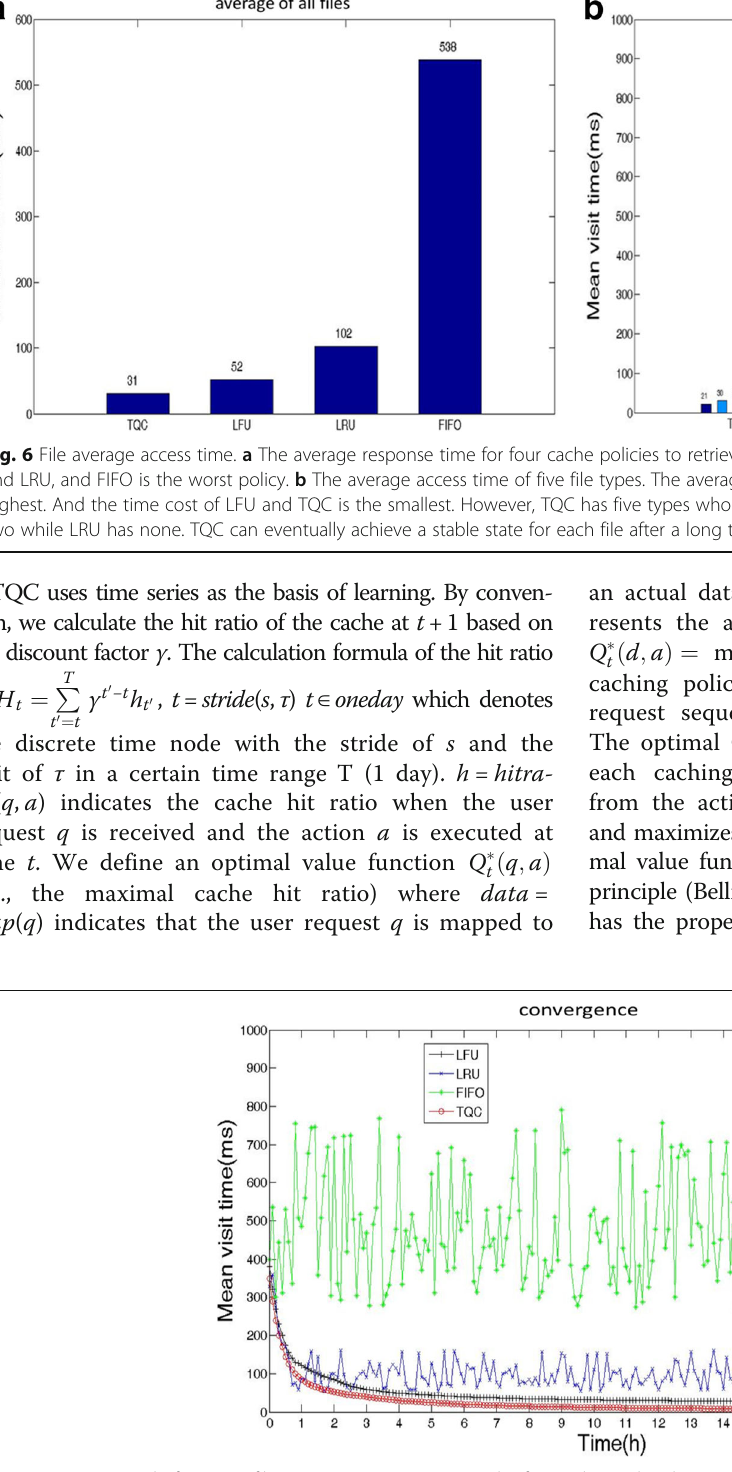
Fig. 7 Variation trend of average file response time over time. The figure shows the changes of average response time for several policies. The average access time for LRU and FIFO is constantly changing due to the variability of the cache contents of LRU and FIFO, resulting in the loss of cache data. Conversely, TQC and LFU do not exhibit this behavior, thus increasing stability. It can be seen that the convergence of TQC is slower than LFU but the average time cost of TQC after convergence is 6 ms and that of LFU is 26 ms. This indicates that the performance of TQC